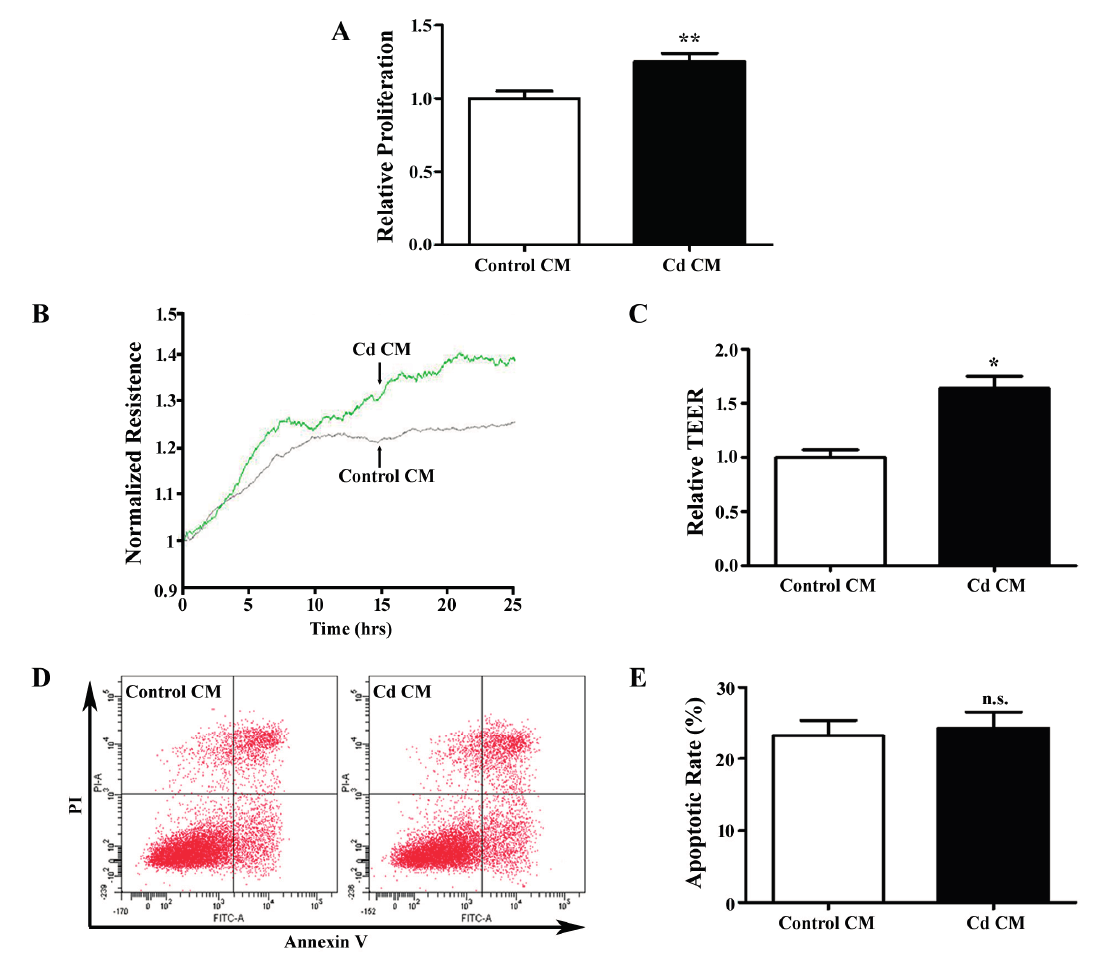
Figure 3. The effects of a Cd-treated A549 cells-derived conditioned medium (CM) on HUVECs. ( A ) MTT assay for HUVECs cells treated with Cd CM. n = 6; ** , p <0.01. ( B ) Real-time transendothelial electrical resistance (TEER) measurement of HUVEC monolayer treated with Cd CM. ( C ) Bar graph of the mean percentage of TEER. n = 4; * , p < 0.05. ( D ) Representative image of flow cytometry with AnnexinV/PI double-staining for HUVECs treated with Cd CM. ( E ) Bar graph of apoptotic rate of HUVECs following flow cytometry. n = 3; n.s.,